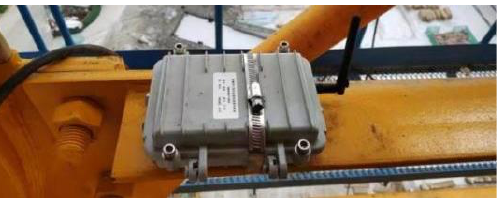
Figure 2. Inclination sensor.